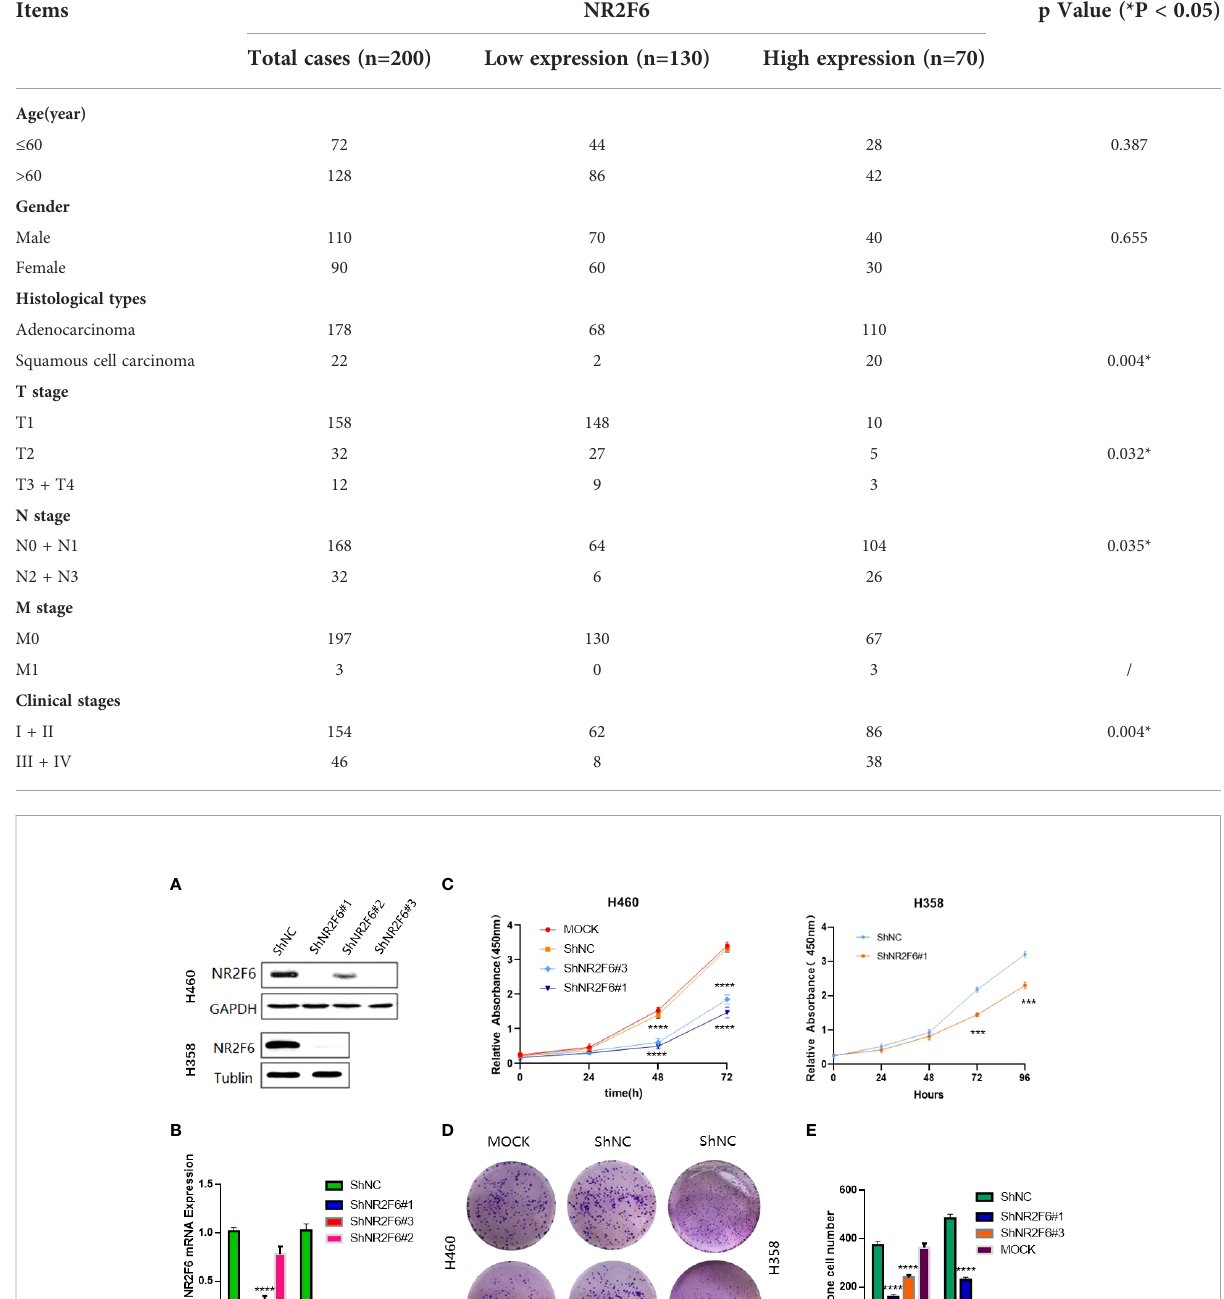
TABLE 1 Relationship between expression of NR2F6 in lung cancer tissues and clinicopathological features of lung cancer.